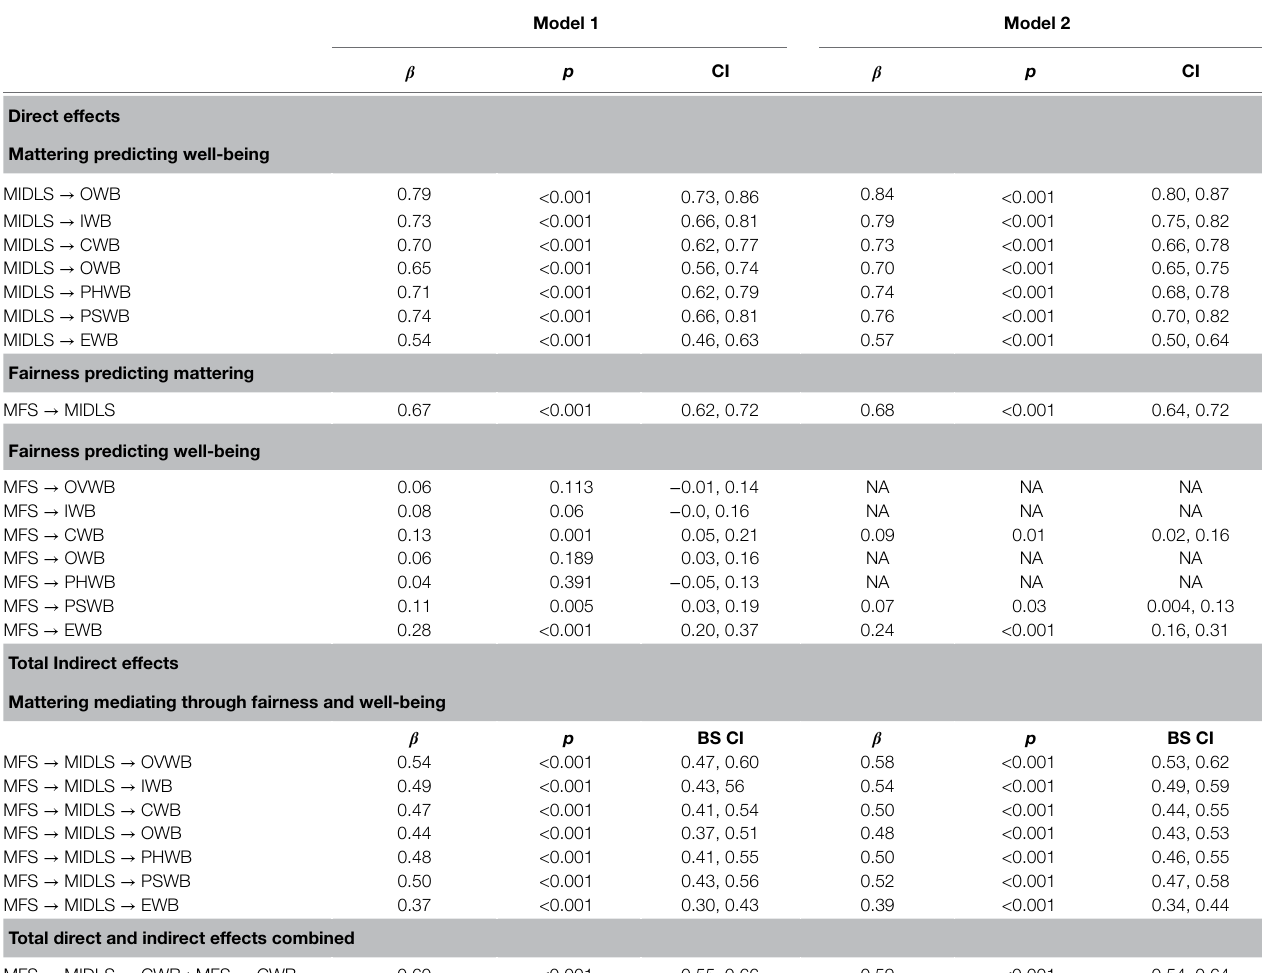
TABLE 3 | Standardized Coefficients for Model 1 and Model